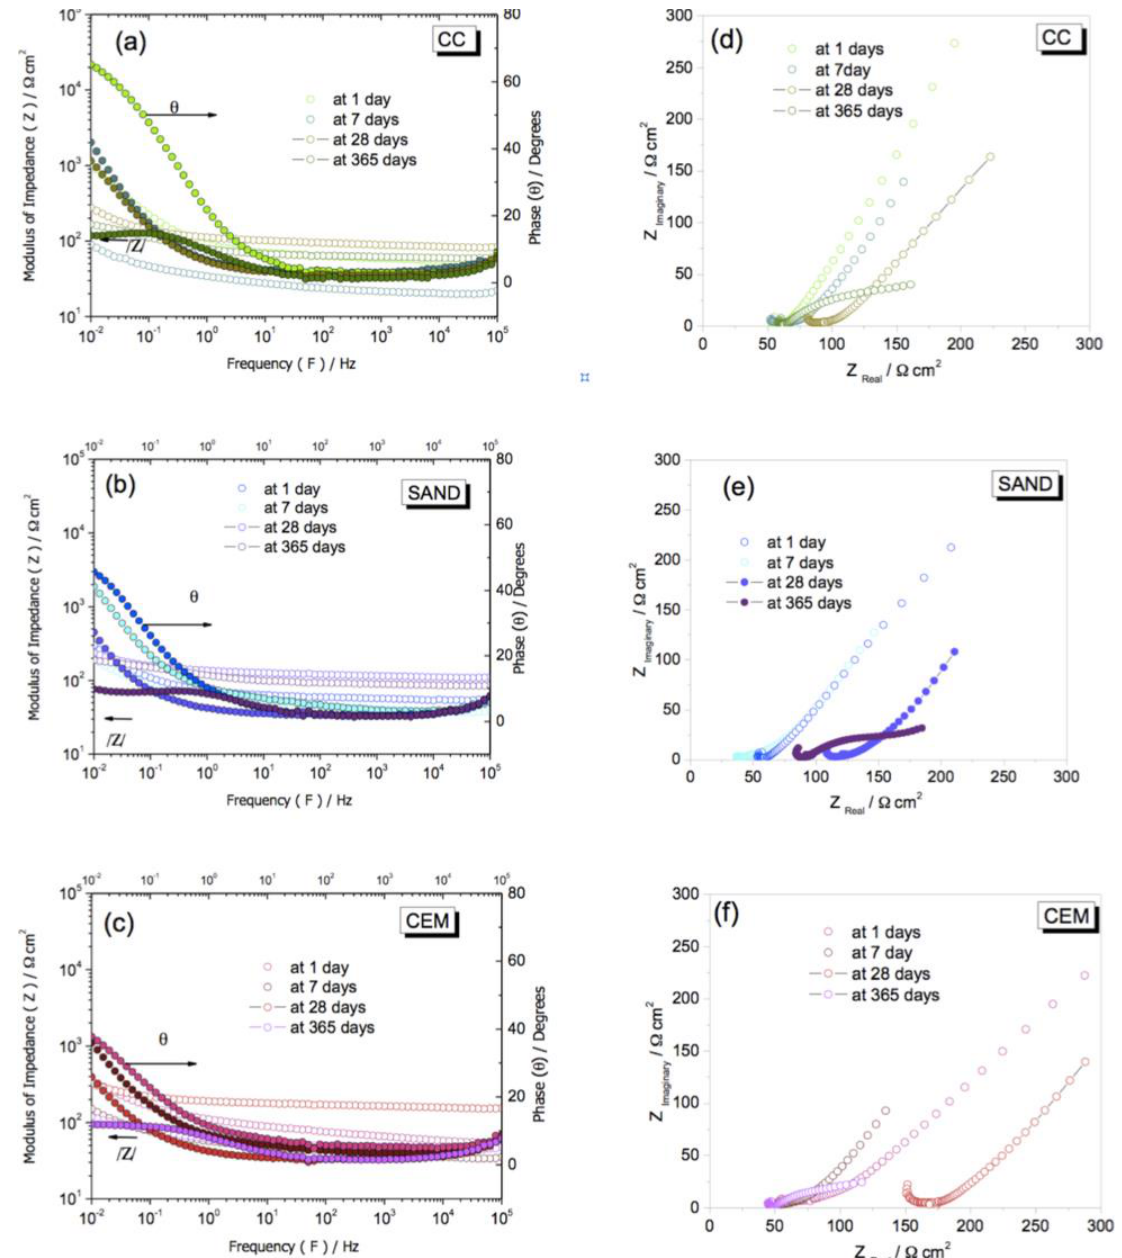
Figure 4. Experimental results of EIS of the CC, SAND and CEM samples at distinct curing/immersion curing periods (1, 7, 28 and 365 days) in a stagnant/naturally aerated 0.5 M NaCl solution. ( a – c ) depicts Bode and Bode-phase plots and ( d – f ) show Nyquist plots in different examined days.